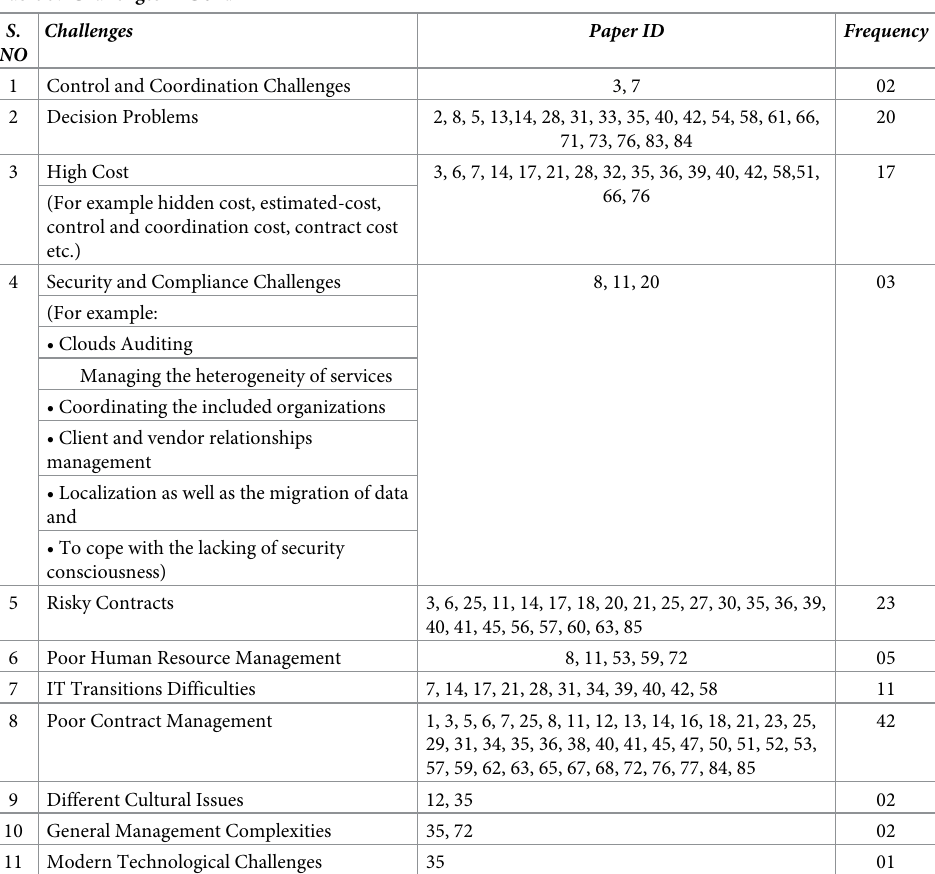
Table 3. Challenges in COR.